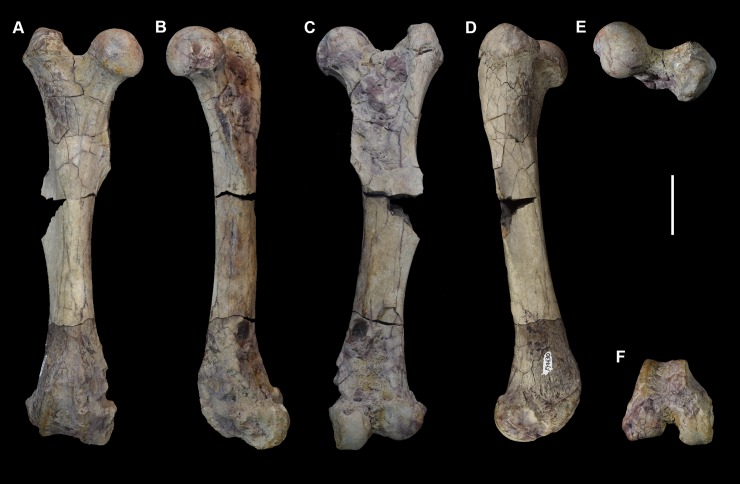
Right femur of Periptychus carinidens (NMMNH P-19430).(A) anterior view; (B) medial view; (C) posterior view; (D) lateral view; (E) proximal view, (F) distal view. Scale bar: 30mm.